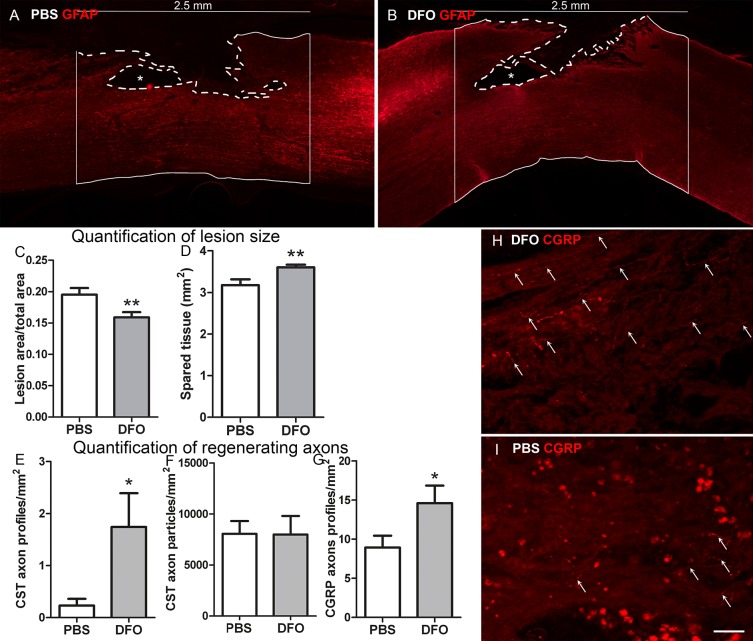
Effects of DFO on scarring and regeneration.Tissue preservation, lesion size and axon regeneration at 19 dpl. (A) Exemplary mosaic compositions of PBS- (A) and DFO- (B) treated spinal cord stained with anti-GFAP to visualize the GFAP-negative scar area. Lesion area marked with dotted lines, Asterisks indicate a cystic area in both treatment groups. S3 Fig provides pictures A and B with higher intensity to show that the lesion site is filled with tissue. Straight lines outline the region of interest used for quantification of lesion site (2.5 mm). DFO animals had significantly smaller lesion areas (corrected for the total area) than PBS controls (C) and significantly more tissue sparing (D) and. (E) Quantification of the number of CST axons per mm2 of lesion area revealed a significant increase. (F) the CST tracing was equal in both groups. (G) The number of CGRP axons in the scar was significantly increased in DFO-treated rats. (H, I) Representative pictures of CGRP axon profiles (arrows) in the lesion area in DFO- and PBS-treated animals. Note that the red spots in I originate from aberrantly stained macrophages. Statistics: unpaired T-test * p < 0.05, ** p < 0.01. Scale bar (G, H) = 50 μm.